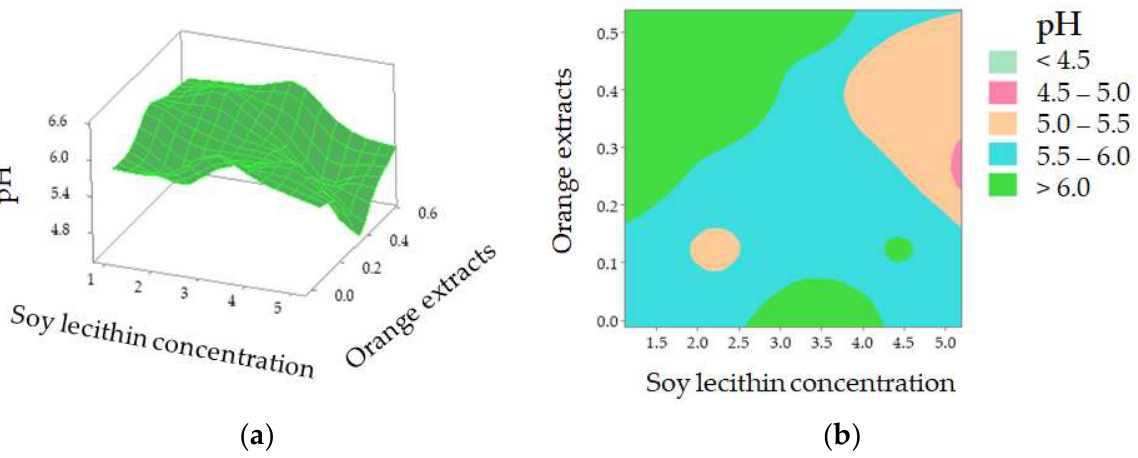
Figure 4. pH value of the sausages stuffed in modified casings as affected by soy lecithin concentration and addition of orange extracts ( a ); 2D contour plot ( b ).